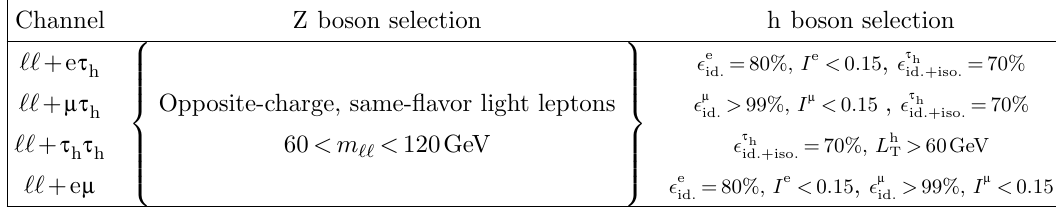
Table 2 . Kinematic selection requirements for each A boson decay channel, applied on top of the looser selections and b jet veto described in the text. The e(cid:14)ciency of the identi(cid:12)cation (and isolation) requirement for a given lepton type is labeled (cid:15) ‘ . The leptons assigned to the Higgs id : boson are required to have opposite charge. To increase the sensitivity, we require m (cid:12)t to be within tt 90{180 GeV. In the ‘‘ + t channel, we additionally require L h > 60 GeV, where L h is the scalar T T h t h p sum of the visible decay products of the Higgs T